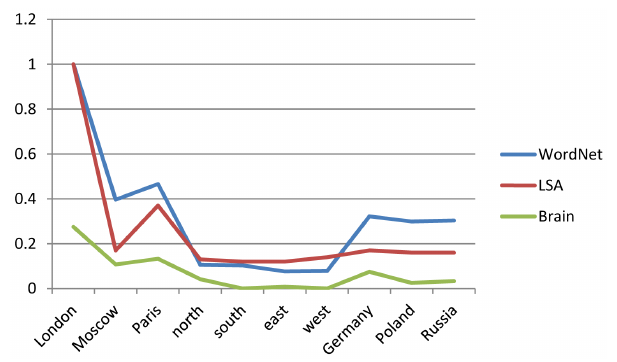
Figure 6. WordNet-based and LSA-based semantic similarities and EEG conditional probability estimates for London relative to London , Moscow , Paris , north , south , east , west , Germany , Poland , and Russia . Data taken from Figure 1, Figure 2, and Figure 4.